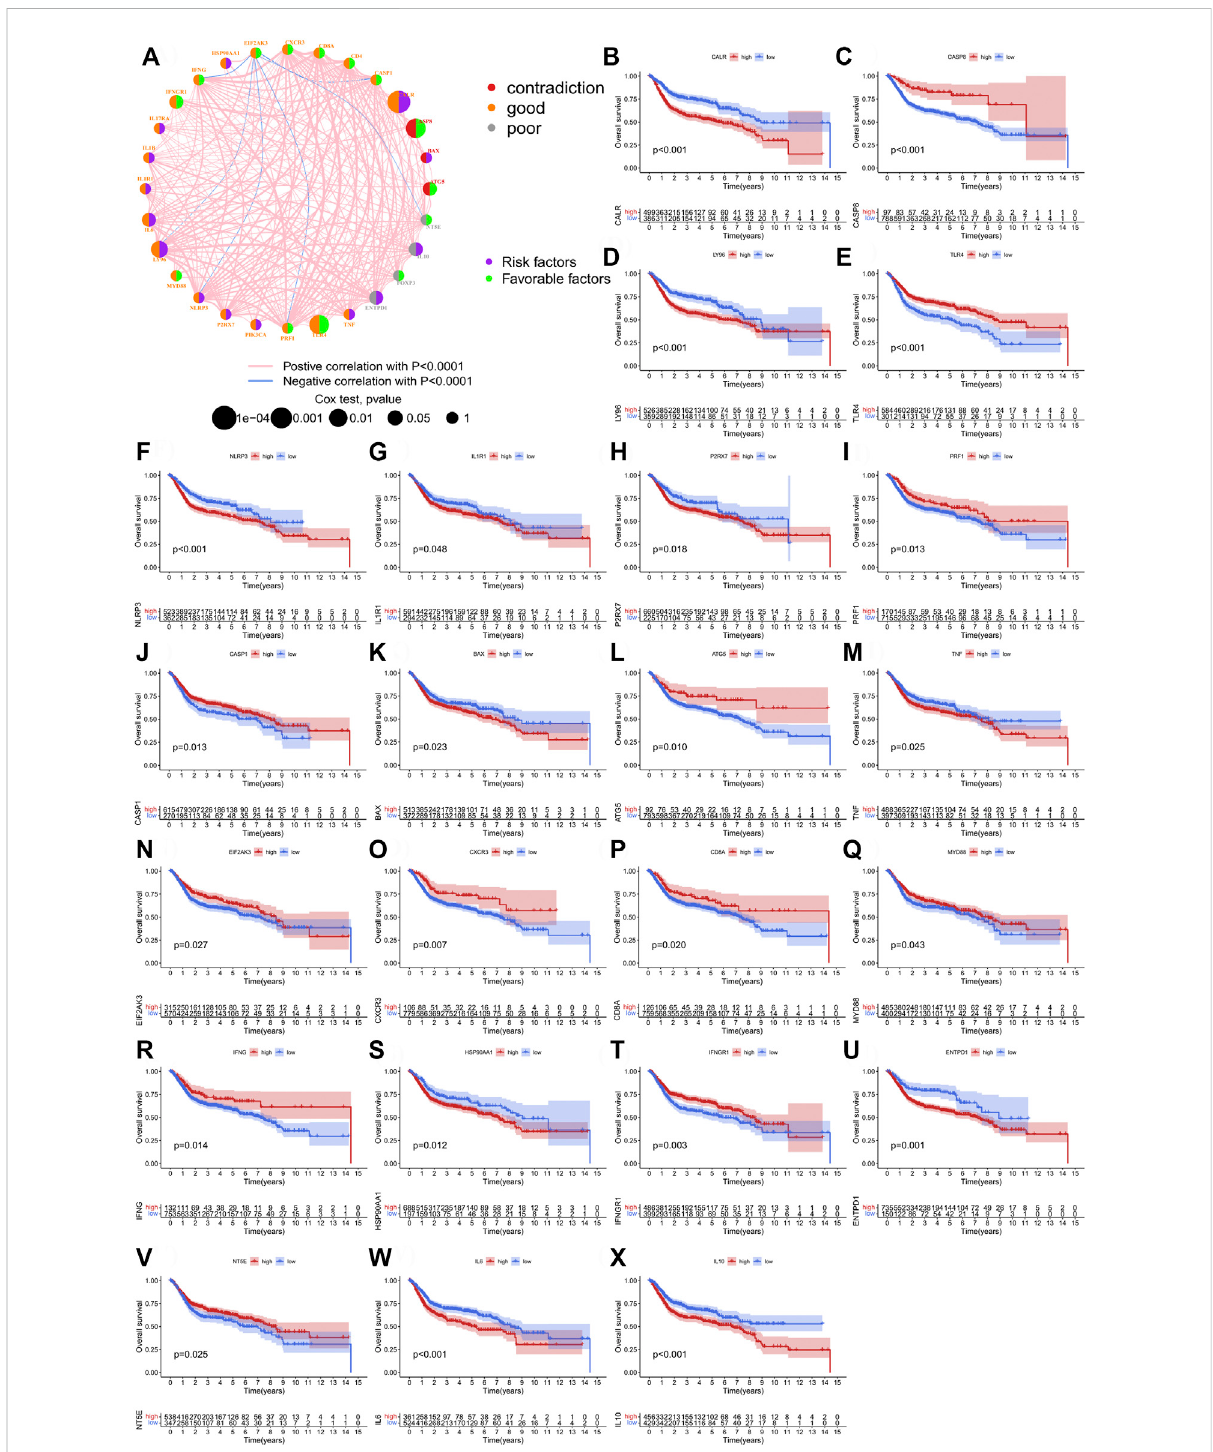
FIGURE 2 The prognostic role of IRGs in the merged cohort. (A) A network illustrating interactions between 28 IRGs. (B – X) Kaplan-Meier analysis of 23 IRGs with prognostic roles in bladder cancer in the merged